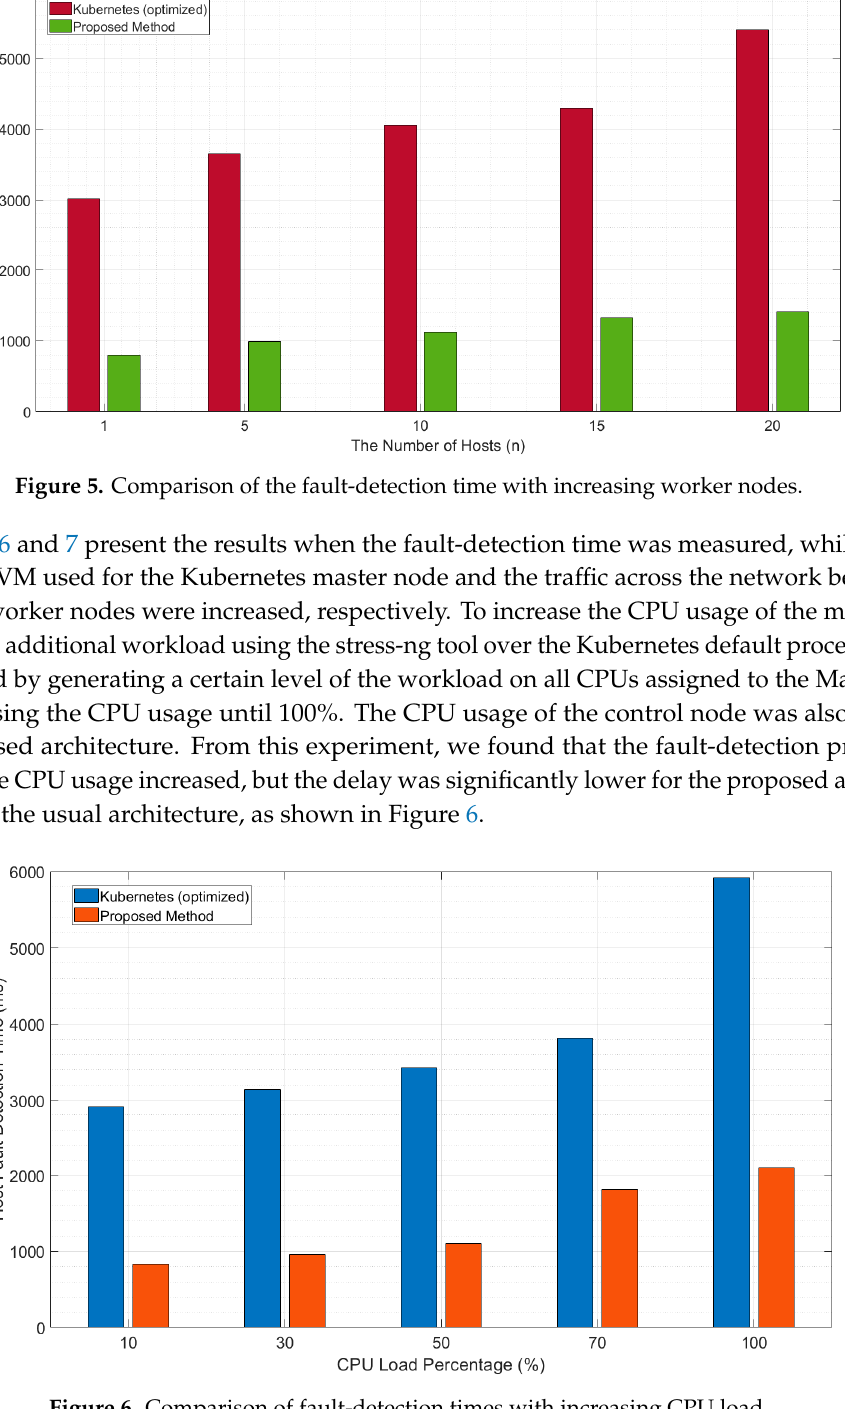
Figure 6. Comparison of fault-detection times with increasing CPU load.